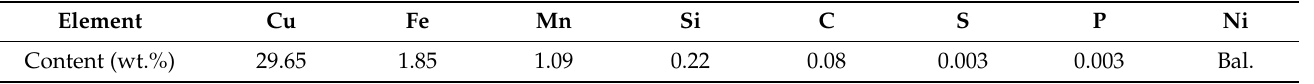
Table 1. Chemical components of the Monel 400 alloy.